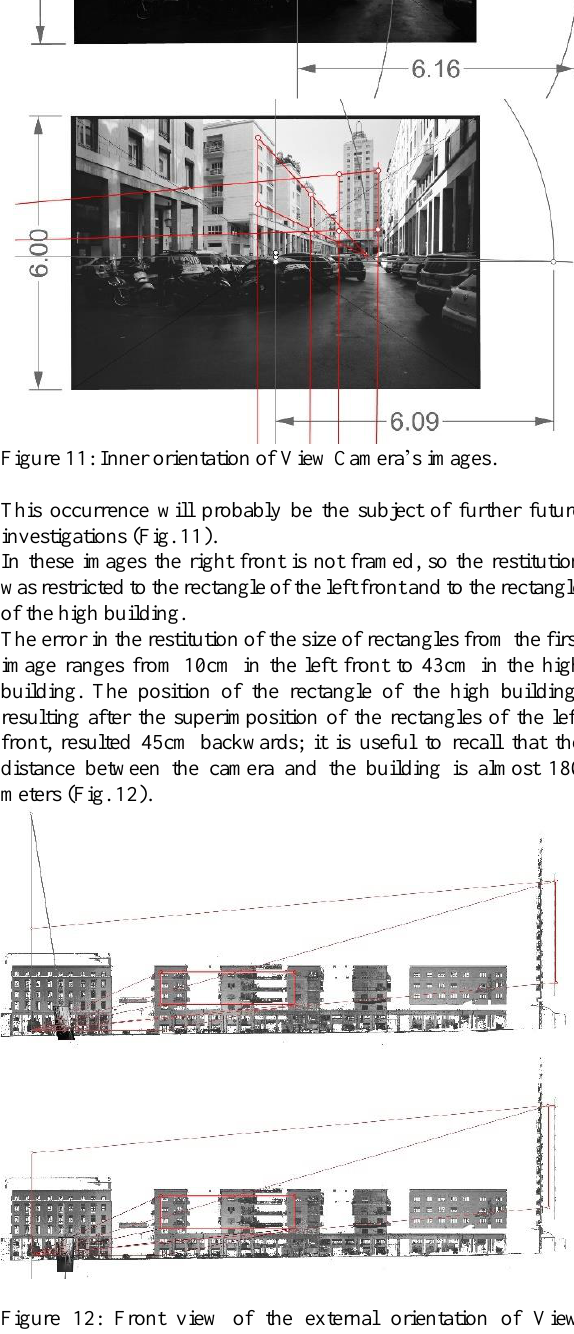
Figure 12: Front view of the external orientation of View Camera’s images in neutral position (above) and with the rear standard tilt correction (below).